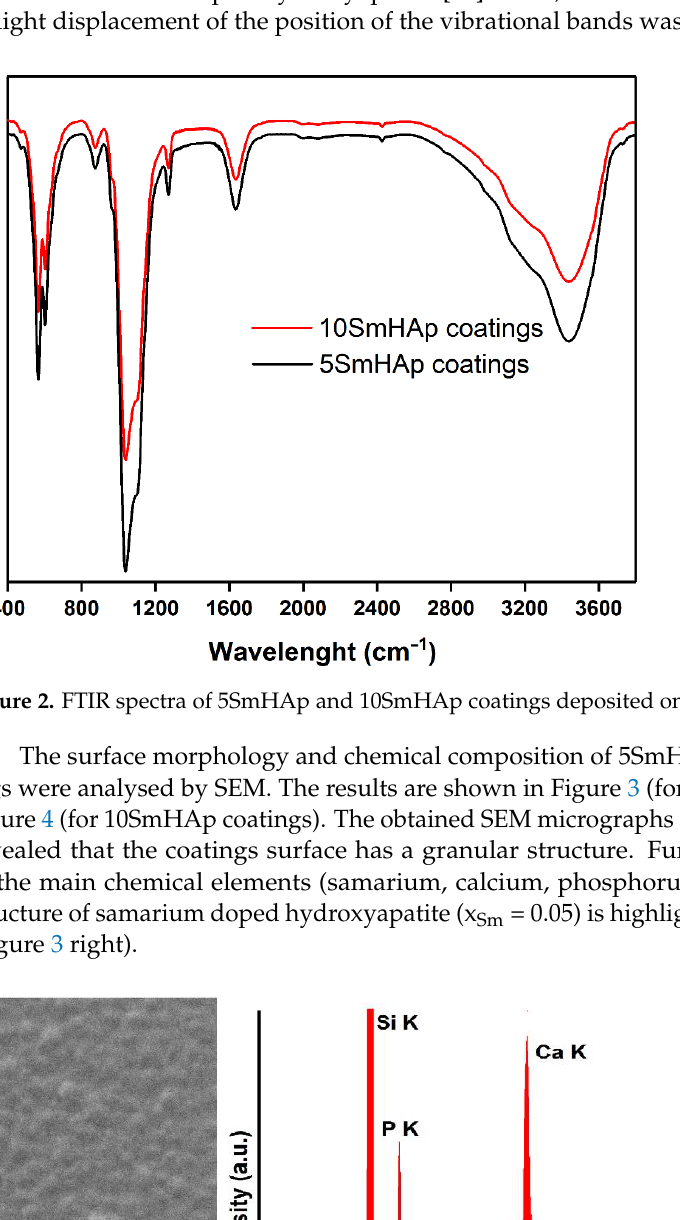
Figure 4. SEM micrograph ( left ) and EDX spectra ( right ) obtained on 10SmHAp deposited in Si substrate. In the Figure 4 (left) could be noticed that the 10SmHAp coatings has a similar gran- ular structure with the one obtained in the case 5SmHAp coatings. Moreover, it can be seen that the granular structure becomes more pronounced with increasing of Sm concen- tration in the samples, this behavior being most likely due to the tendency of agglomera- tion of nanoparticles [25]. Also, the EDX spectra obtained on 10SmHAp confirm the pres- ence of the main chemical elements (samarium, calcium, phosphorus and oxygen). More- over, in the case of both samples could be noticed that the coatings present no cracks or other discontinuities. In both cases the maximum of Si in the EDX spectra is due to the substrate on which the coatings were deposited. The obtained EDX spectra also revealed and highlighted the coatings purity by the absence of the impurities in the obtained spec- tra. 3.2. Antimicrobial Activity The SmHAp coatings did not exhibit antimicrobial activity at concentration of 5 mg/mL against the tested Gram-positive ( Staphylococcus aureus 25923 ATCC, Enterococcus faecalis 29212 ATCC) and Gram-negative bacteria ( Escherichia coli 25922 ATCC, Pseudomo- nas aeruginosa 27853 ATCC) and fungal strain ( Candida albicans ATCC 10231). The effects of the tested compounds on the bacterial attachment and biofilm formation are given in